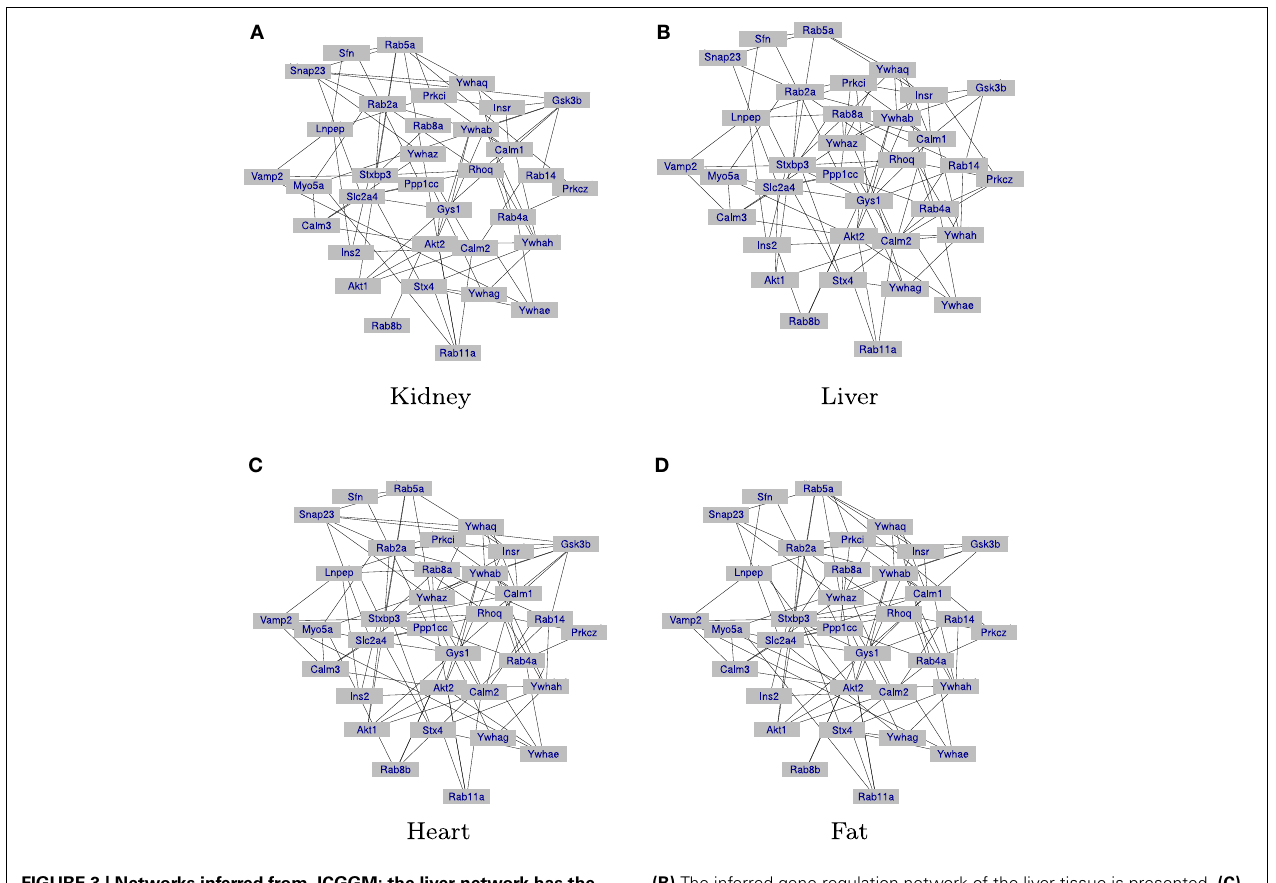
(B) The inferred gene regulation network of the liver tissue is presented. (C) The inferred gene regulation network of the heart tissue is presented. (D) The inferred gene regulation network of the fat tissue is